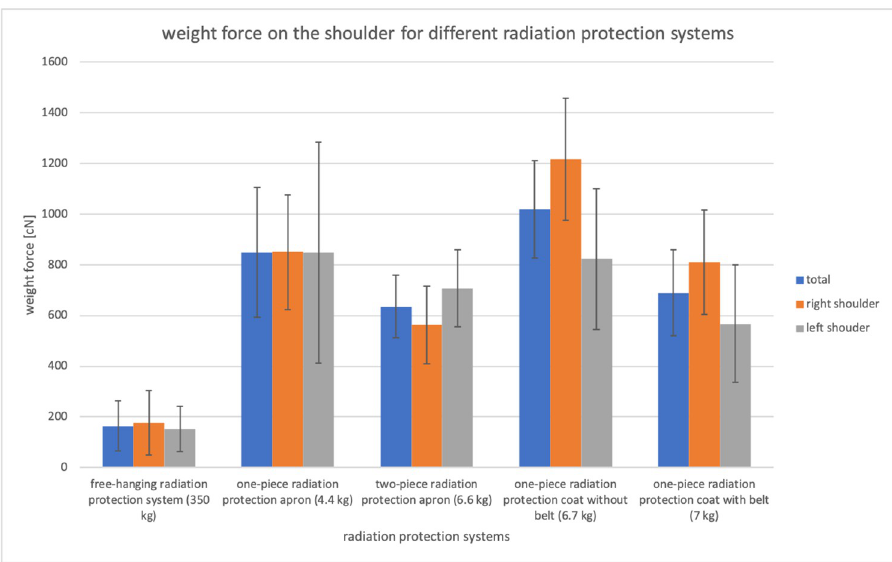
Fig 3. The shoulder load of the different radiation protection aprons averaged and their standard deviation over all movements is shown. The load is listed both as average value over both shoulders and for each individual shoulder. The total weight of the free-hanging radiation protection system is significantly lower than the other systems investigated. Furthermore, the weight of the two-piece radiation protection apron is significantly lower than that of the one-piece radiation protection systems. For the one-piece radiation protection coat with and without a belt a significant difference between the right and left shoulder could be measured.